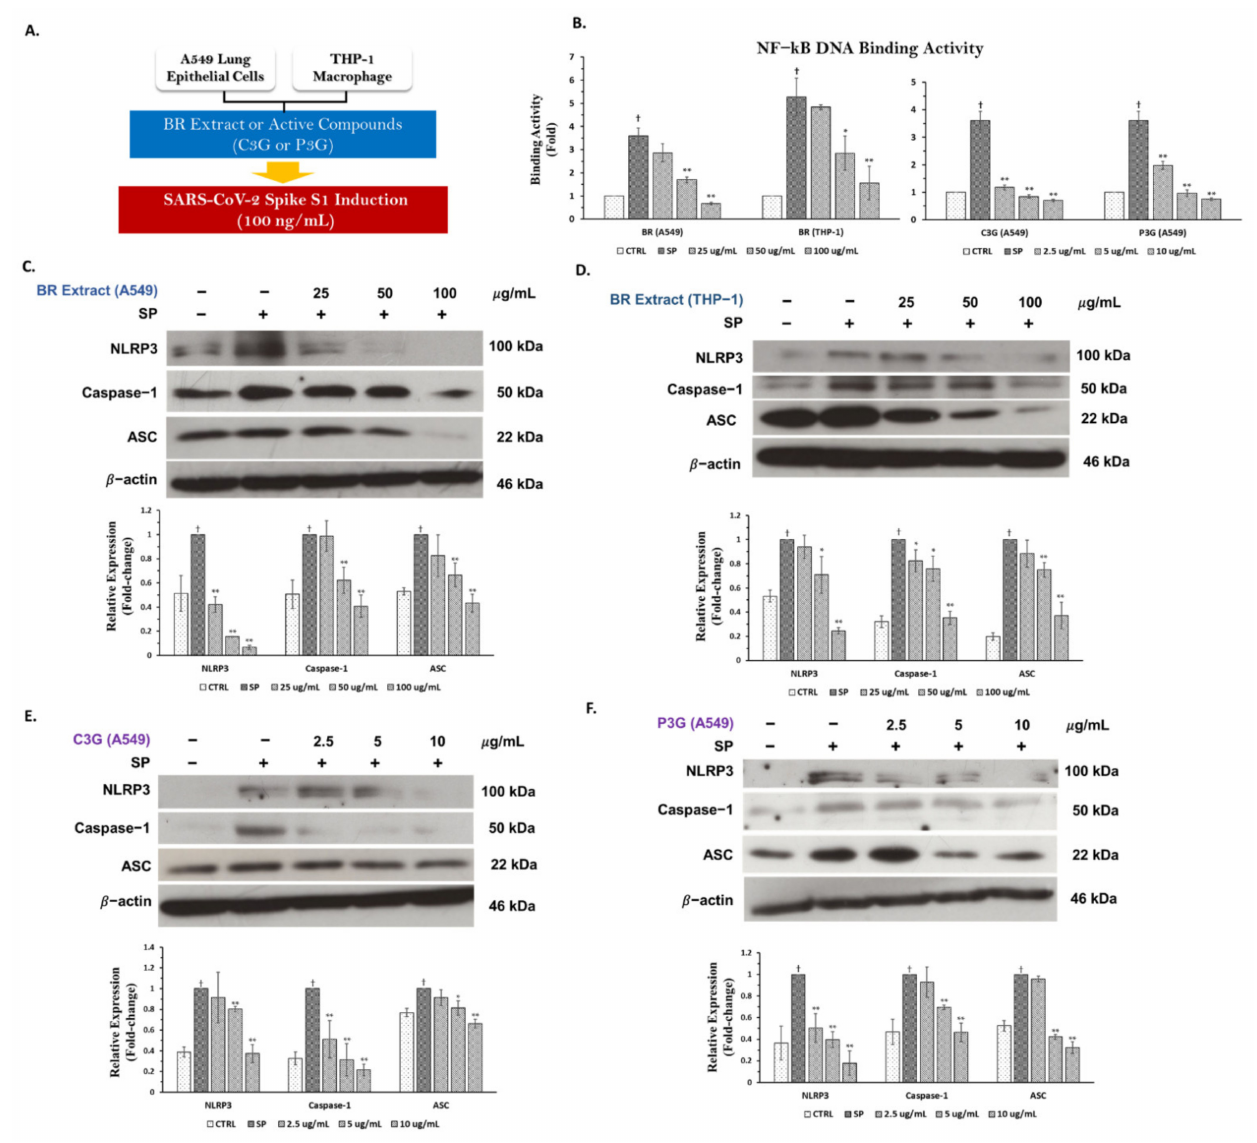
Figure 7. BR extract and its active compounds C3G and P3G exhibited anti − inflammatory properties through the inhibition of NLRP3 inflammasome pathway in A549 lung cells and THP − 1 macrophages. A549 cells (at 3 × 10 5 cell/well) and PMA − treated THP − 1 macrophage (6.5 × 10 5 cell/well) were pre − treated with the BR extract at the concentration of 0 − 100 µ g/mL or C3G and P3G at the concen- tration of 0 − 10 µ g/mL for 4 h, and then challenged with 100 ng/mL of SP for 3 h ( A ), then the cell lysates were collected. Cells were kept and determined for the inhibition of inflammasome machinery proteins including NLRP3, caspase − 1, and ASC using Western blot analysis. The inhibitory effects of BR extract and active anthocyanins on NF − kB transcriptional activity in nuclear extracts ( B ). The inhibitory effects of the BR extract in A549 cells ( C ) and in THP − 1 cells ( D ), C3G ( E ), and P3G ( F ) on NLRP3, caspase − 1, and ASC proteins displayed in western blots and band density measurements. * p < 0.05, ** p < 0.01 vs. SP − induced control group. † p < 0.05 vs. non − treated control